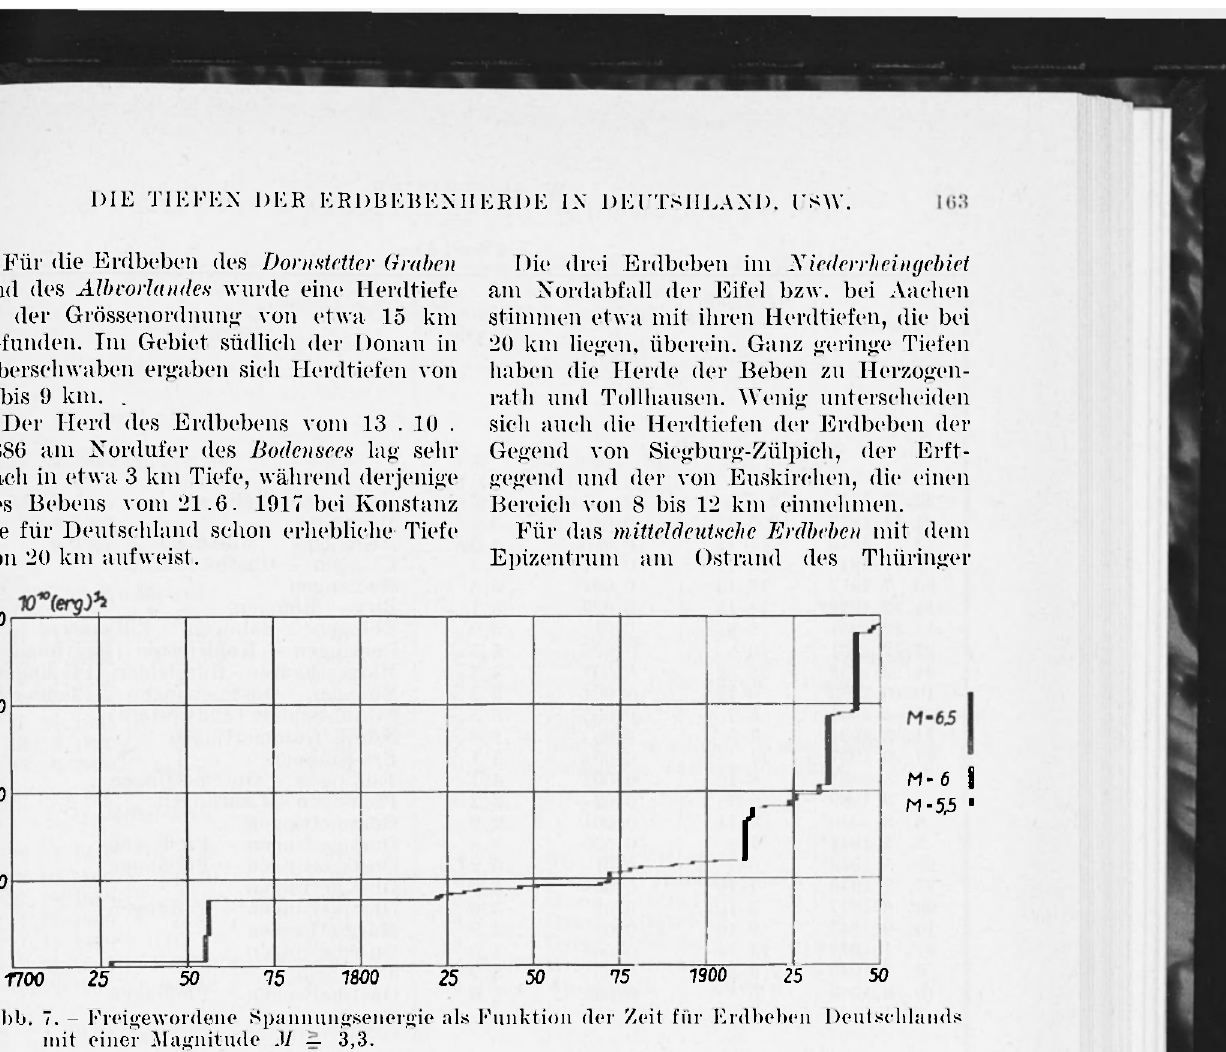
Abb. 7. - Freigewordene Spannungseiieì'gie als Funktion der Zeit fiir Erdbeben Deutsclilands mit einer Magnitude M — 3 ,3. Die Erdbeben der mitleren Schivarzivald- region haben Herdtiefen von 8 bis .13